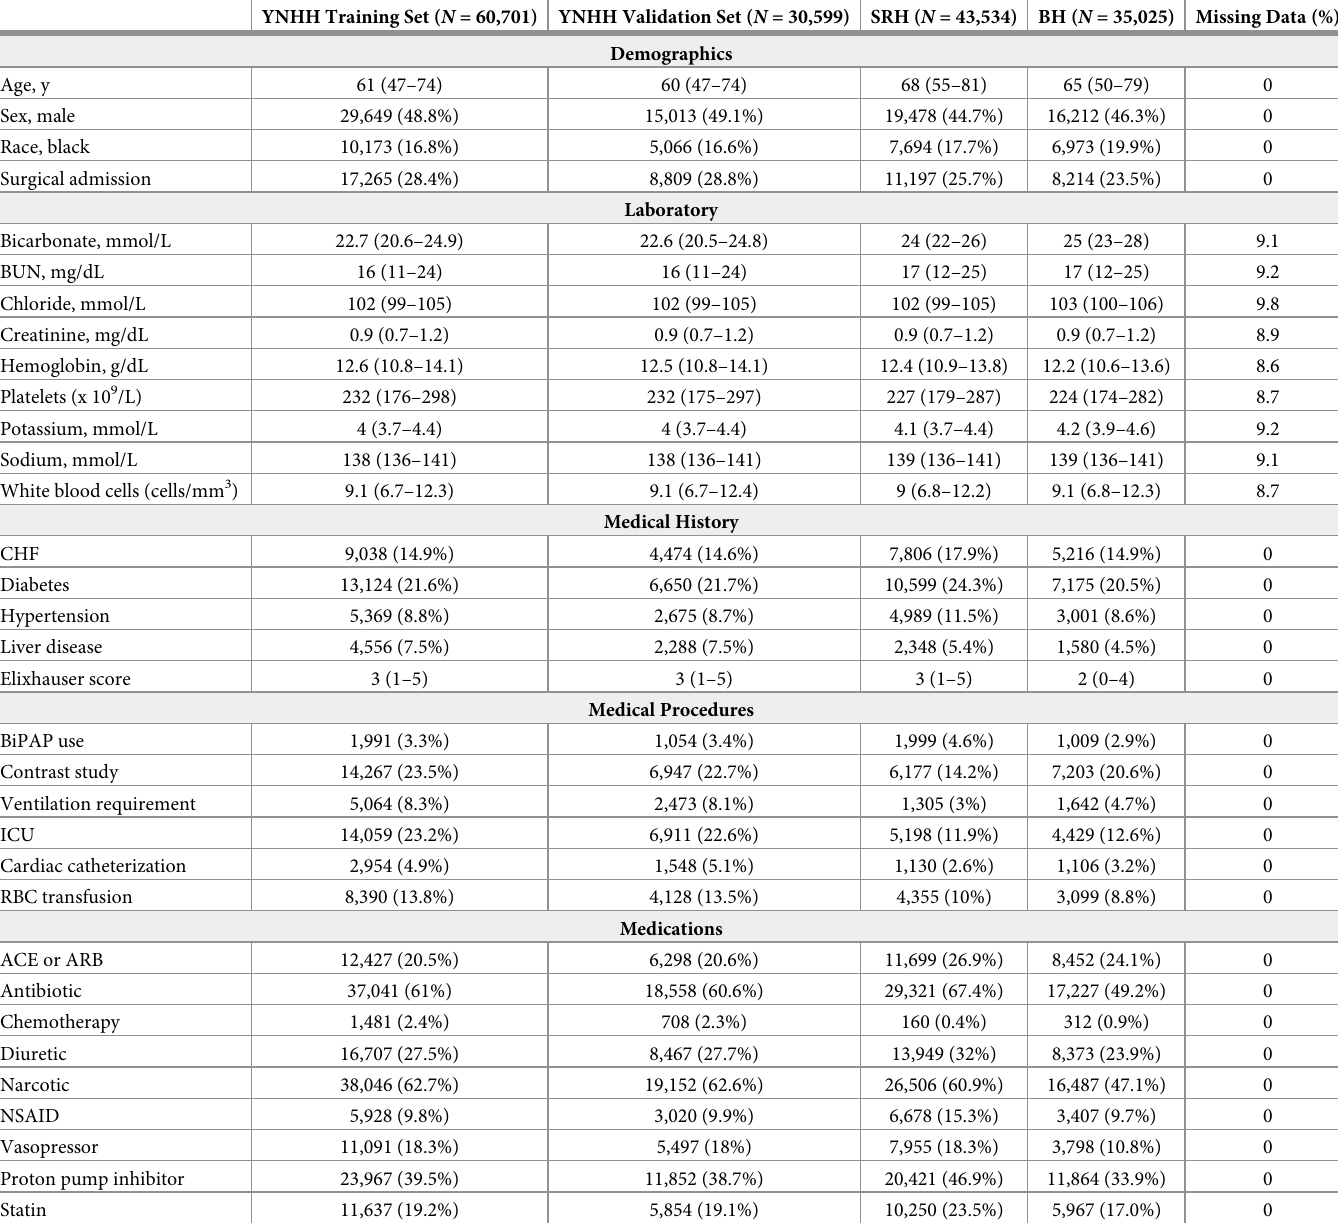
Table 1. Baseline patient characteristics. Baseline patient characteristics in the training and validation sets. Data is in count (%) or median (IQR). There is significant dif- ference across the data sets for all variables listed here at P < 0.001. Missing data is provided as a percentage of total time points included in the model ( N = 22,743,165). YNHH Training Set ( N = 60,701) YNHH Validation Set ( N = 30,599) SRH ( N = 43,534) BH ( N = 35,025) Missing Data